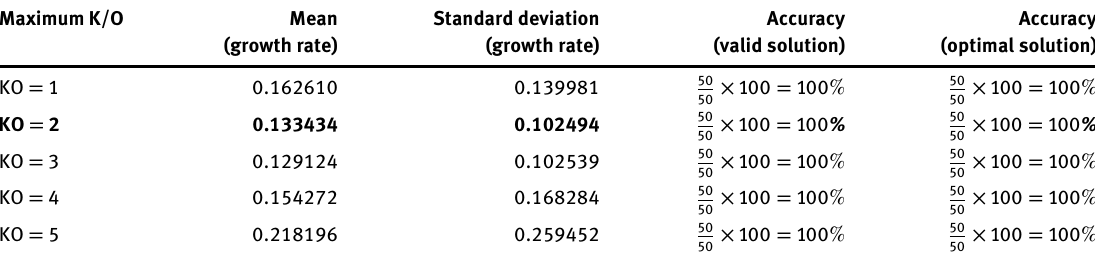
Table 6: Performance measurement of lactate